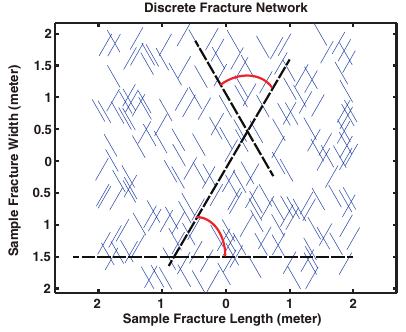
Figure 4. An example of discrete fracture